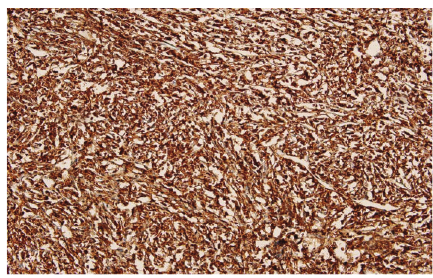
Figure 3: Paraffin immunostaining studies showed strong positivity of the neoplastic cells for leucocyte commen antigen (LCA).